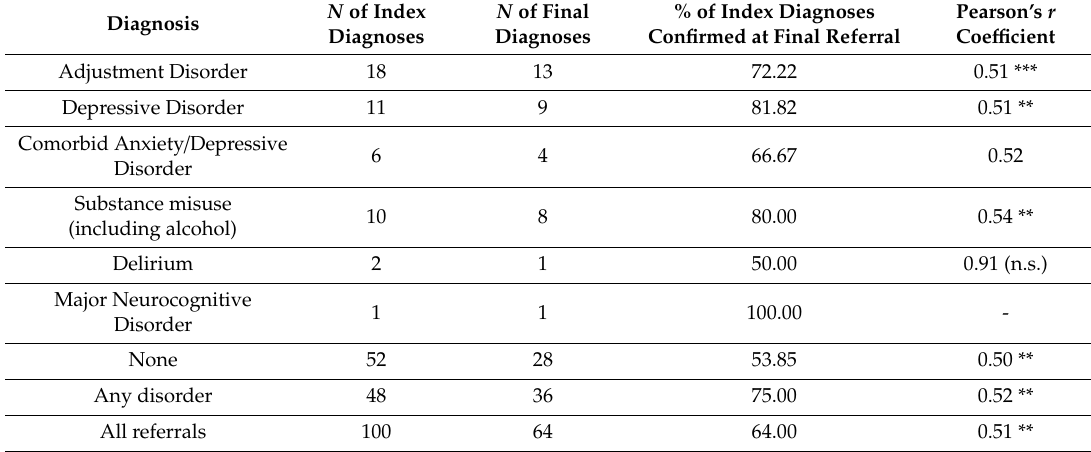
Table 1. Number of diagnoses established at the index referral confirmed at the final referral (disaggregated by type of